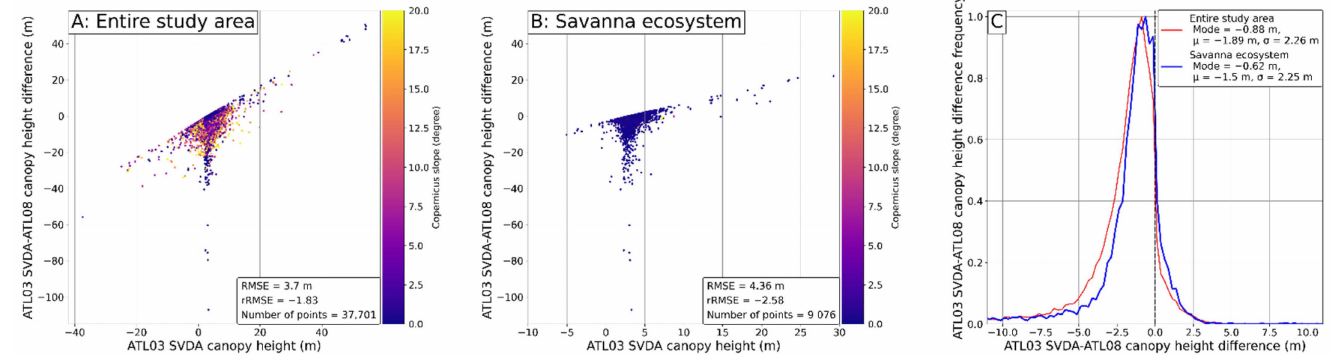
Figure 10. ATL03 SVDA and ATL08 canopy height relationship ( A , B ) for the study areas shown red and blue polygons in Figures 1B,C and 2. ( C ) The full distribution of canopy height differences, showing height differences of several meters in places and generally higher values of ATL08 estimates. rRMSE shows the relative RMSE (RMSE/mean of canopy height